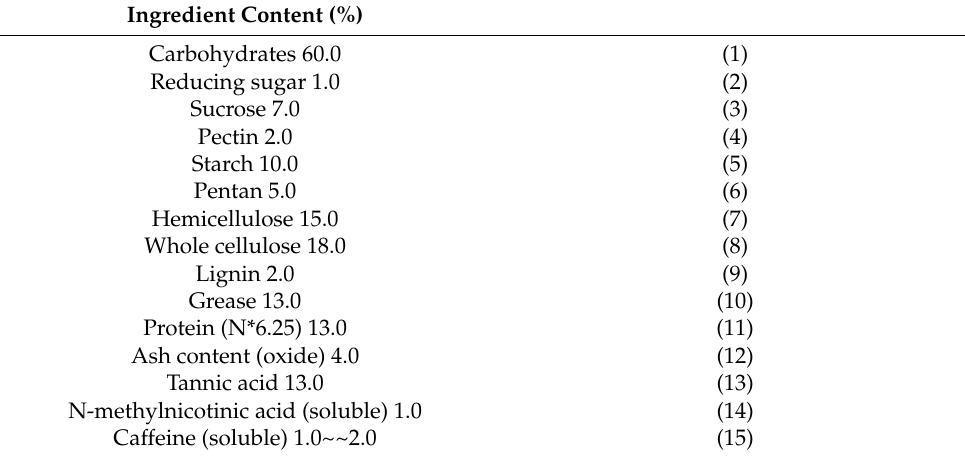
Table 1. The main chemical composition of raw coffee